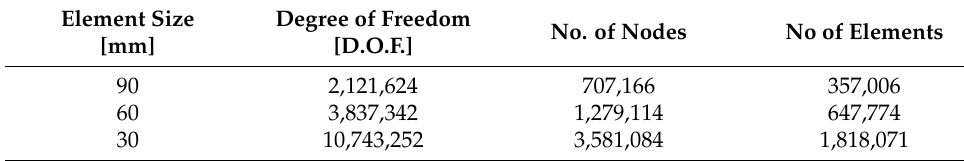
Table 2. Comparison table from mesh element dimension point of view.